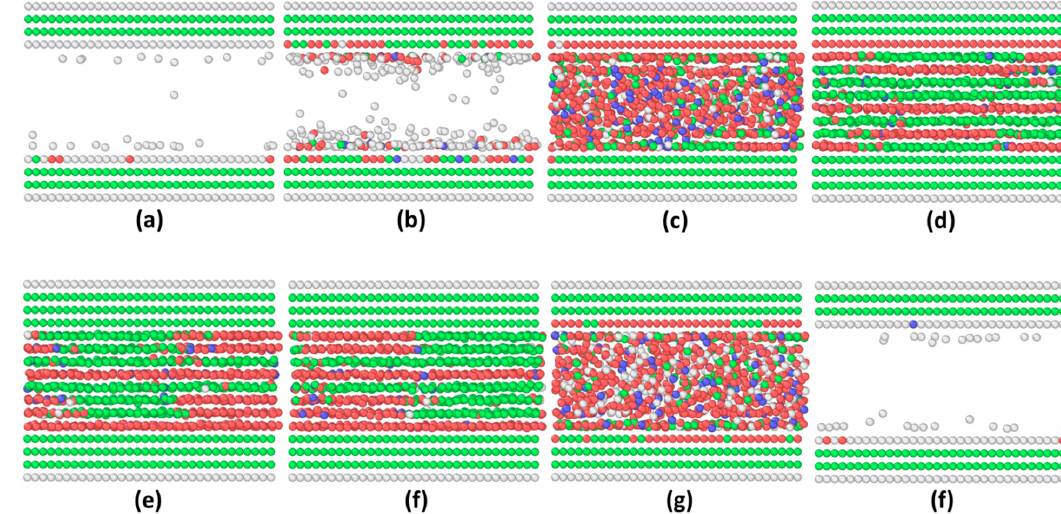
Figure 5. The GCMC snapshots of atomic configurations of adsorption-desorption isotherms for argon molecules confined between two commensurate contacts at 85 K for n = 8 monolayer thickness. Adsorption: ( a ) μ = − 2.40 kcal/mol, ( b ) μ = − 2.21 kcal/mol, ( c ) μ = − 2.19 kcal/mol, and ( d ) μ = − 2.0 kcal/mol. Desorption: ( e ) μ = − 2.20 kcal/mol, ( f ) μ = − 2.275 kcal/mol, ( g ) μ = − 2.35 kcal/mol, and ( h ) μ = − 2.40 kcal/mol.